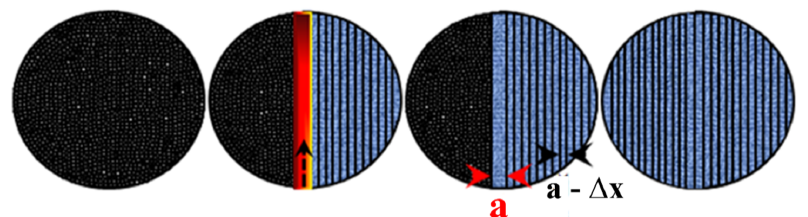
Figure 10. Schematics showing the hatch distance and hatch overlaps observed during the selective laser melting process [12].